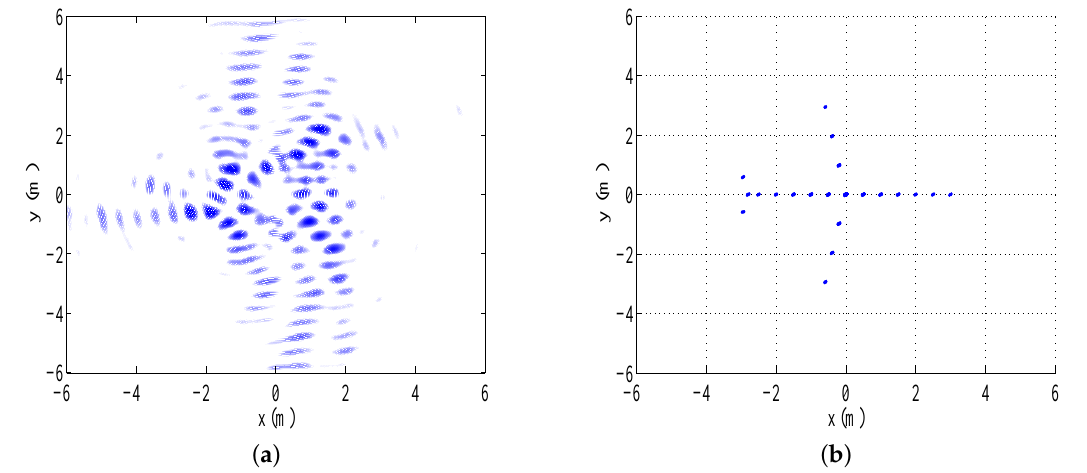
Figure 6. Passive radar images obtained by using different methods: ( a ) reconstructed image with the polar format algorithm (PFA); and ( b ) reconstructed image with the proposed